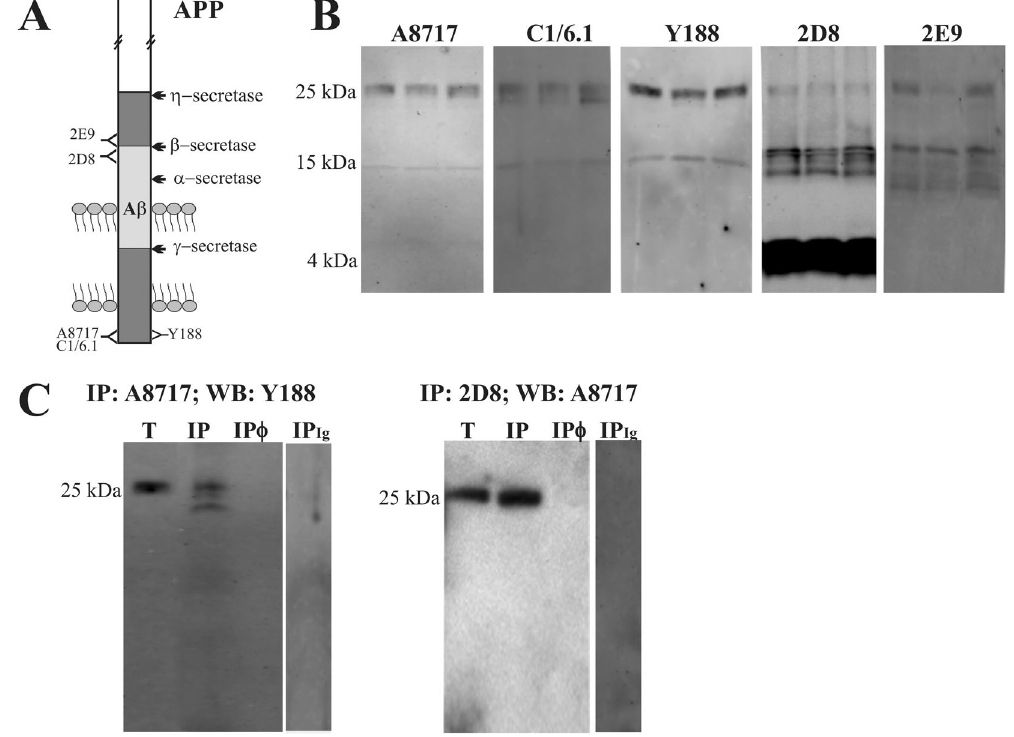
Figure 1. Soluble CTFs of APP are present in human CSF. ( A ) Schematic representation of full-length APP processing by secretases. The epitopes for the antibodies used in this study are indicated. ( B ) Western blotting of three human CSF samples from non-demented controls subjects, resolved with the indicated antibody (samples were the same between different blots). ( C ) CSF aliquots (Total, T) were immunoprecipitated with the indicated antibody, and precipitated proteins (bound fraction, IP) were immunoblotted with the indicated alternative antibody. CSF aliquots incubated with protein A-Sepharose in the absence of capture-antibody (IPø) or with an irrelevant IgG (IP Ig ; a rabbit IgG for A8717 IP and a rat IgG for 2D8 IP), were analyzed in parallel as negative